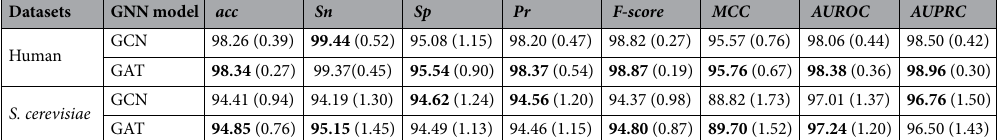
Table 5. Average results of 5-fold cross-validation of GNN variants using LSTM-based LM node features for PPI datasets. Best values are in bold.